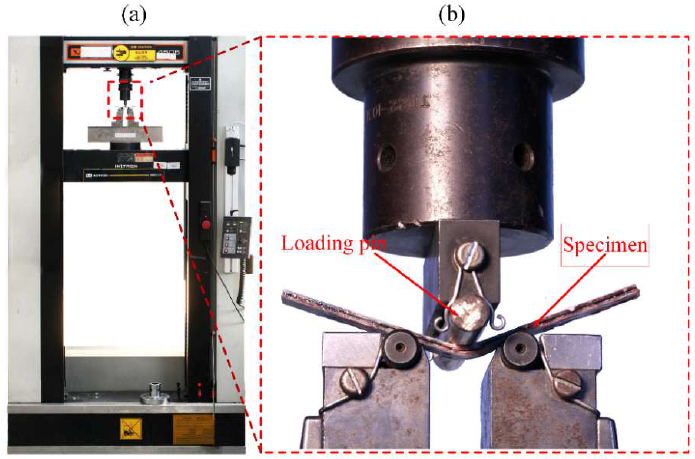
Figure 4. Photograph of flexural testing configuration ( a ) Instron testing machine ( b ) Flexural test specimen.